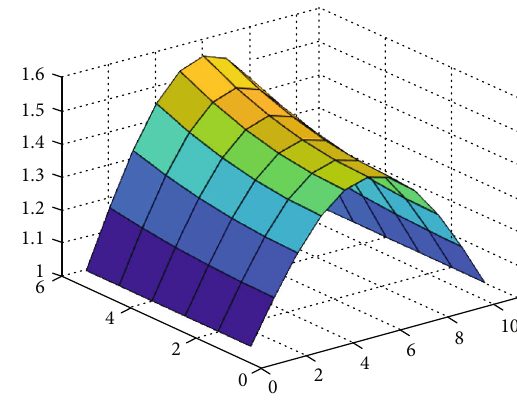
Figure 2: p = 2 , k = 0 : 5 .